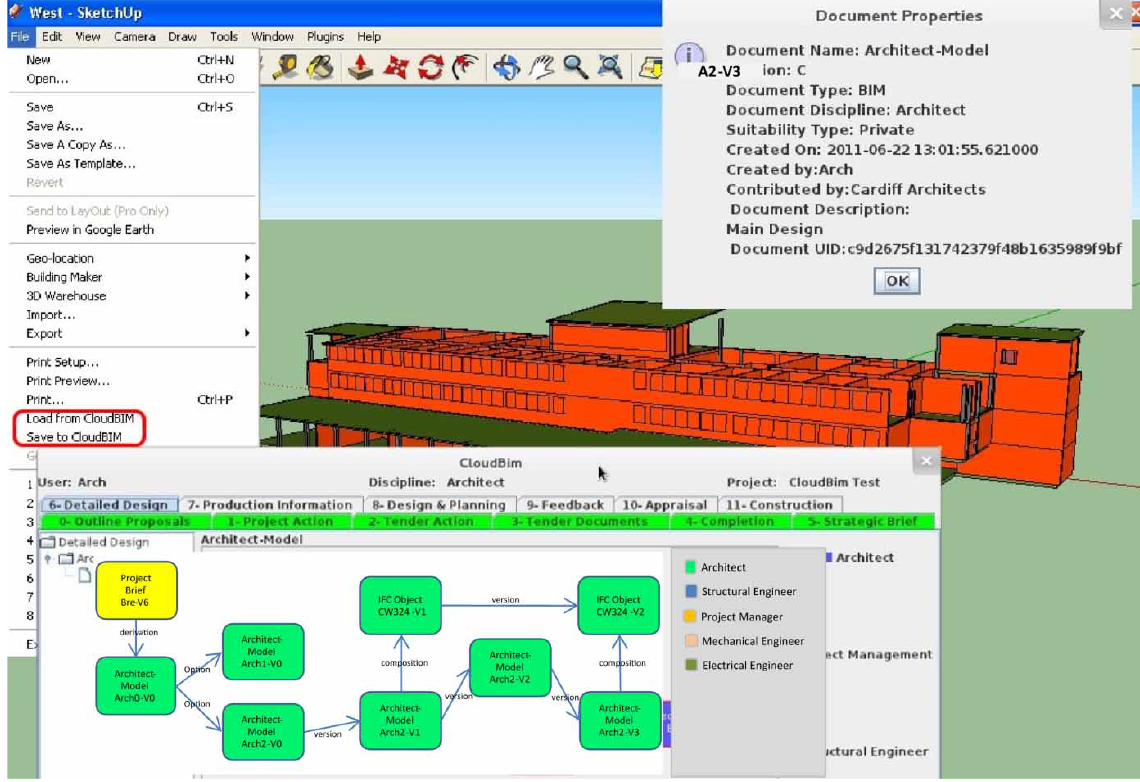
Fig. 11. CloudBIM prototype demonstrator with a focus on the architectural design